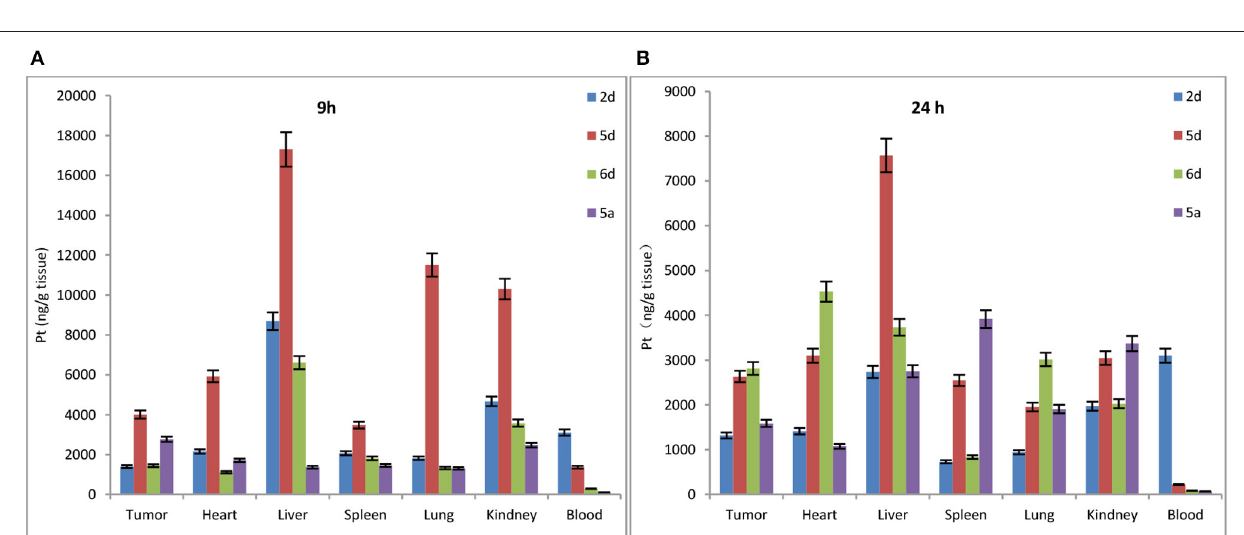
(20 mL) at 60 ◦ C with yields of 60% and 55%, respectively. 1b and 2b were prepared from oxoplatin 2a (1 equiv) or 4a (1 equiv) and succinic anhydride (1 equiv) in anhydrous DMSO at room temperature overnight. DMSO was removed under a